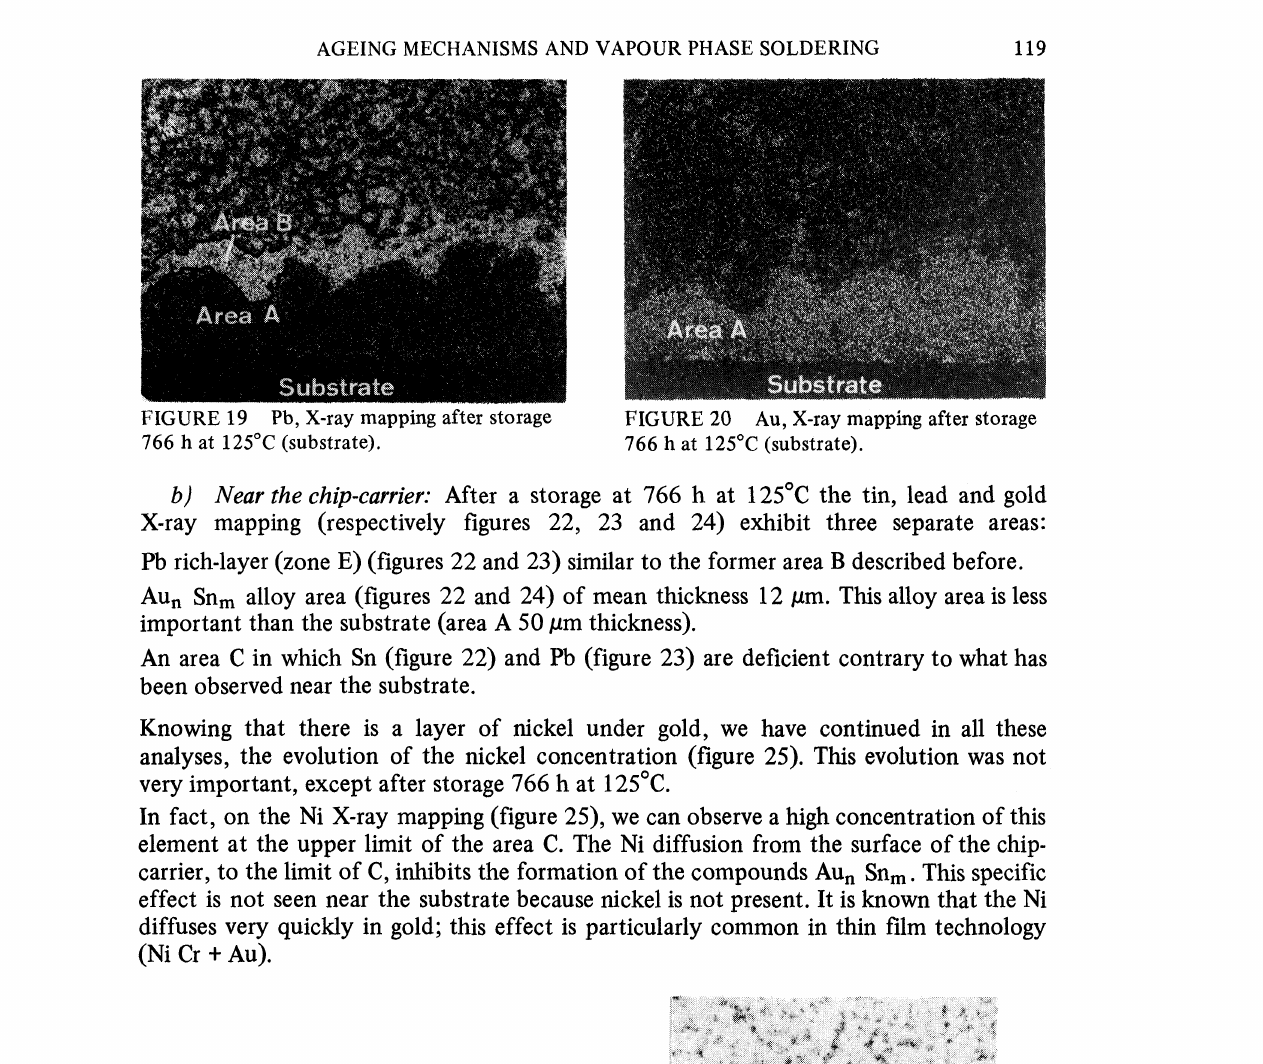
FIGURE 22 Sn, X-ray mapping after storage 766 h at 125C